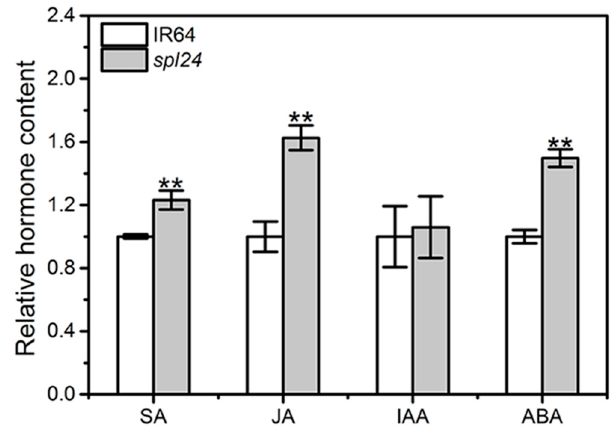
Figure 6. Plant hormone contents in spl24 and IR64. The level of plant hormone in IR64 was normalized to 1. Values indicate means ± SD ( n = 3). ** denote p ≤ 0.01 by Student’s t test.